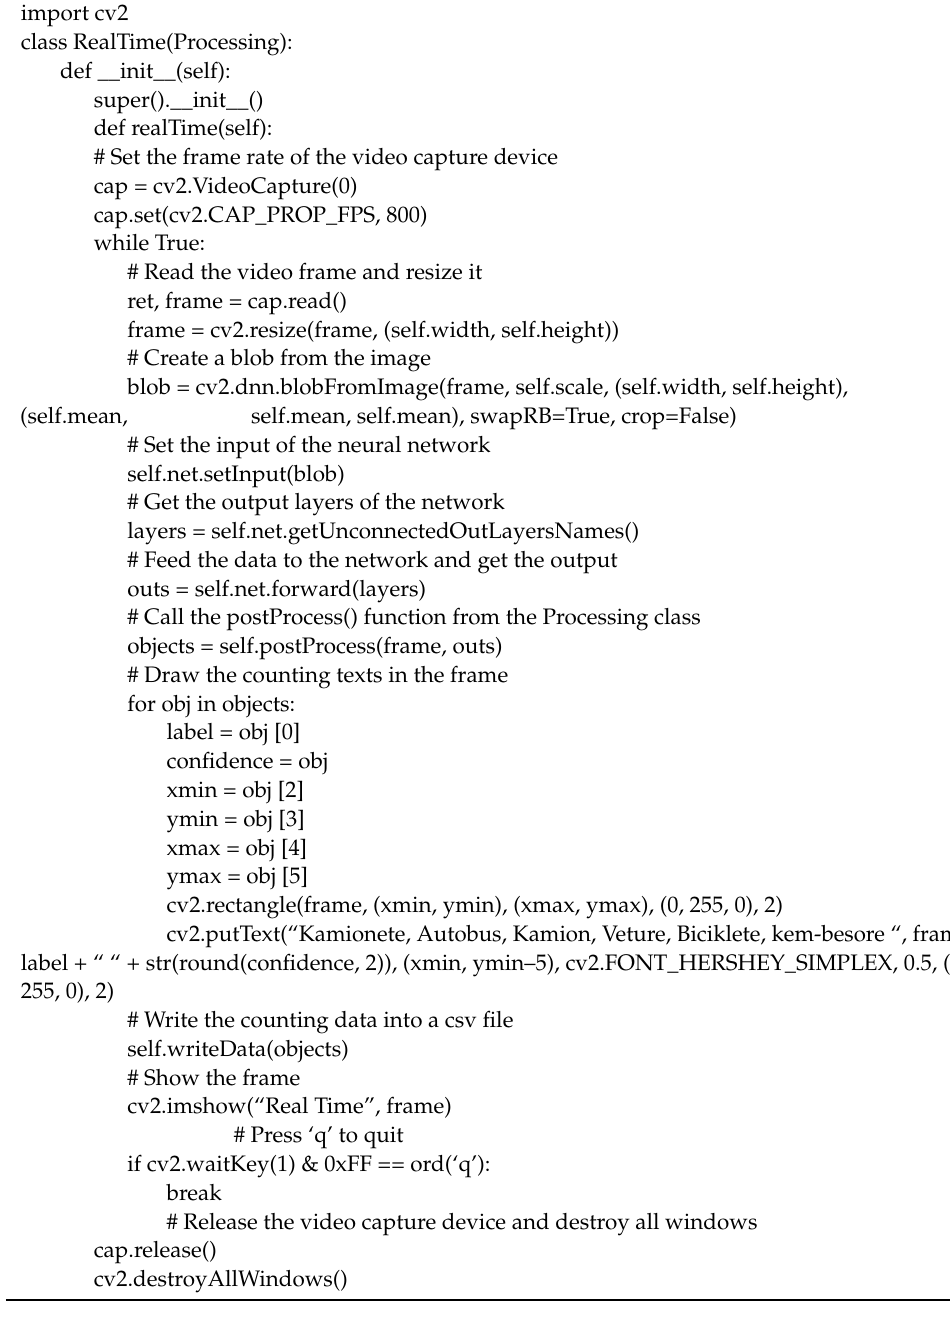
Algorithm 2: Part of the algorithm for counting and categorizing vehicles during automatic counting through